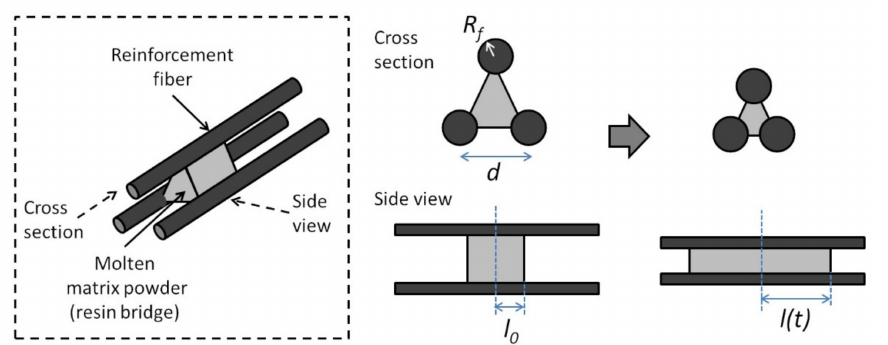
Figure 8. Model of resin bridge between fibers during the consolidation of powder impreg- nated